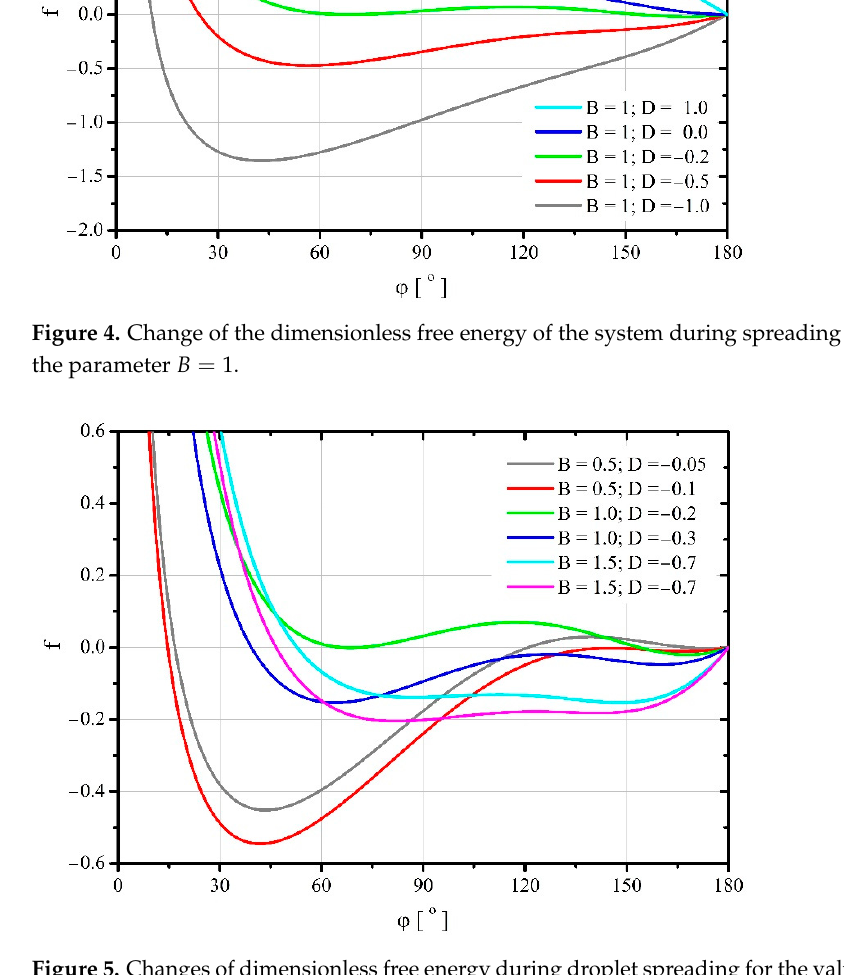
Figure 5. Changes of dimensionless free energy during droplet spreading for the values of parameters 𝐵 and 𝐷 for which there are two stable minima of this function.